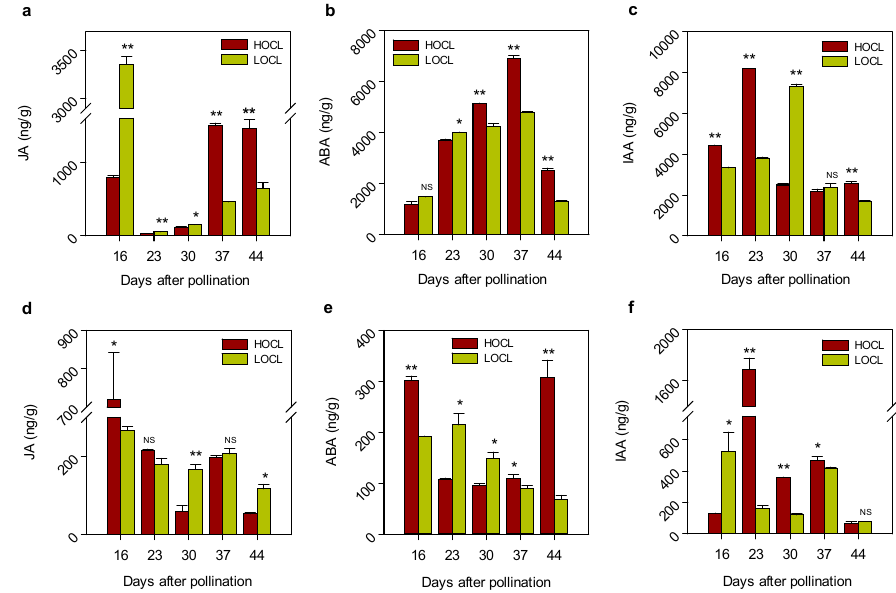
Figure 10. Comparison of hormone content in seed and SW between the HOCL and LOCL during seed development. ( a – c ) Jasmonic acid, abscisic acid, and indole acetic acid in seed. ( d – f ) Jasmonic acid, abscisic acid, and indole acetic acid in SW. Error bars represent standard error ( n = 3). * and ** indicate significant difference and NS indicates no significance between the HOCL and LOCL at p < 0.05 and p < 0.01 levels, respectively (one-tailed t -test).